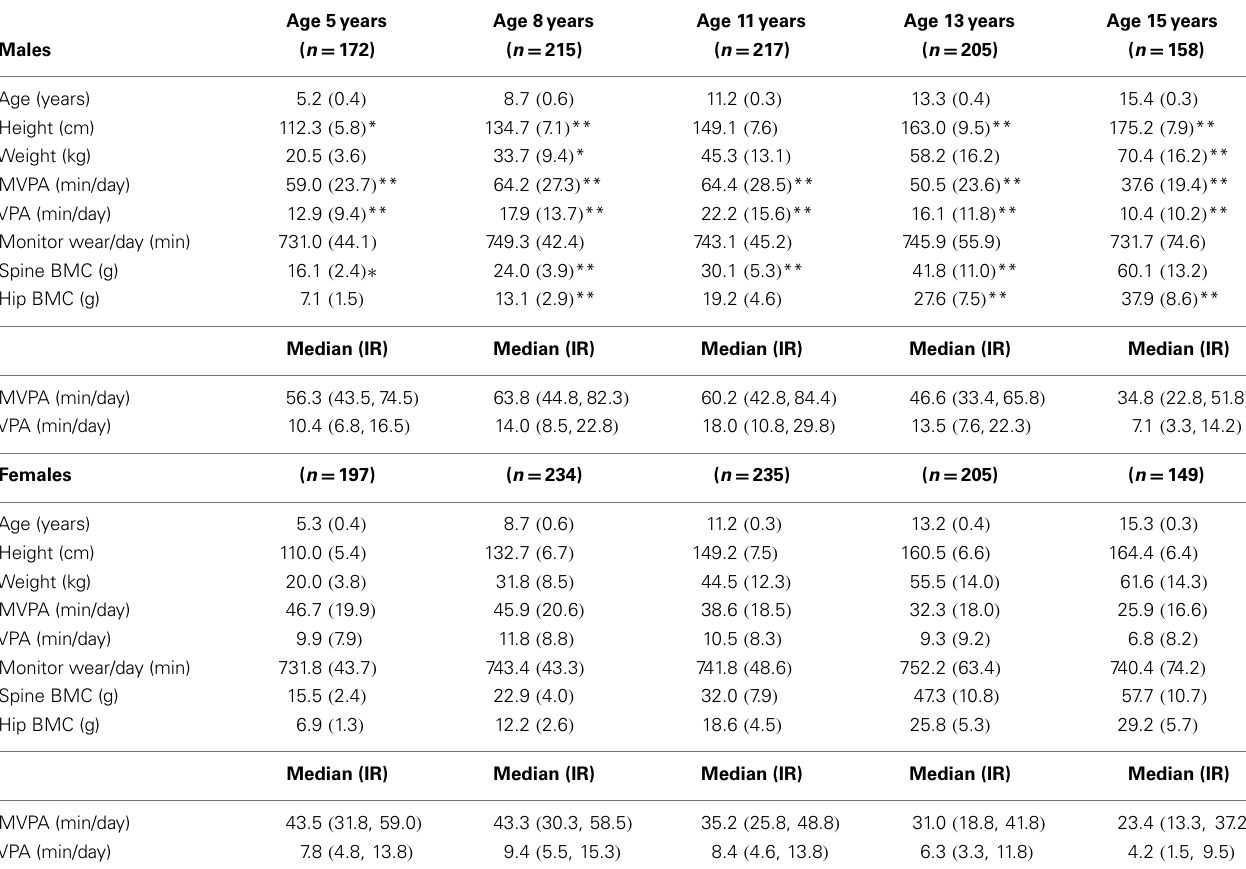
Table 1 | Characteristics of the participants by sex and age